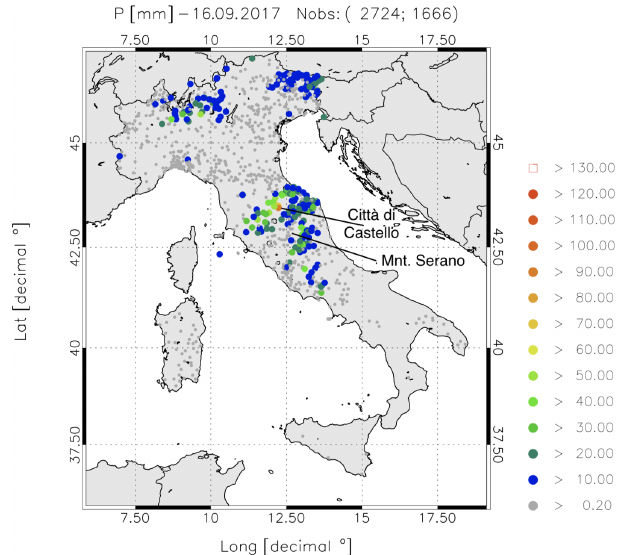
Figure 1. Daily precipitation over Italy on 16 September 2017. Only rain gauges observing at least 0.2mmd − 1 are shown. The first num- ber in the figure title within brackets represents the available rain gauges, while the second number represents rain gauges observing at least 0.2mmd − 1 . The lowest precipitation class is represented by smaller dots, the largest by a red square. The locations of Città di Castello and Mount Serrano are